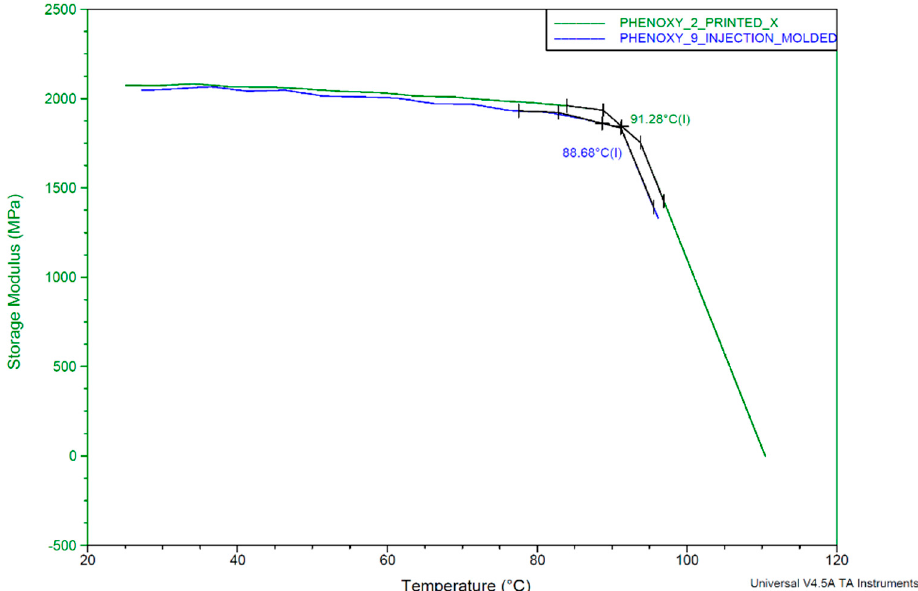
Figure 12. Result of dynamic mechanical analysis (DMA) measurement. Green curve: 3D printed, blue curve: injection molded.